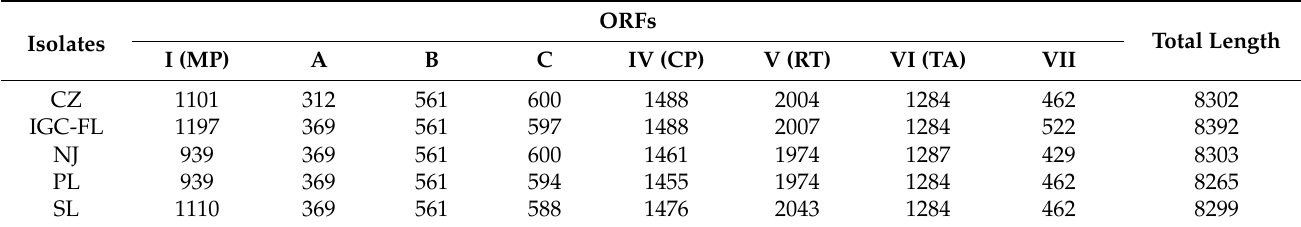
Table 5. Nucleotide length of each ORFs in different BRRV isolates from Florida and other regions. Adapted from [5].